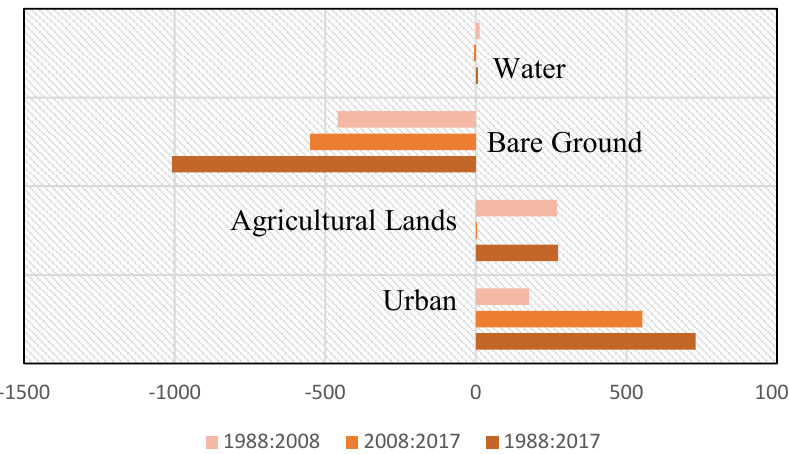
Figure 5. Total LULC net change for the entire study area including desert lands. Agricultural Lands are seen to be growing presumably due to government reclamation efforts, thus the results are not entirely representative of what is occurring throughout the rest of the ND.